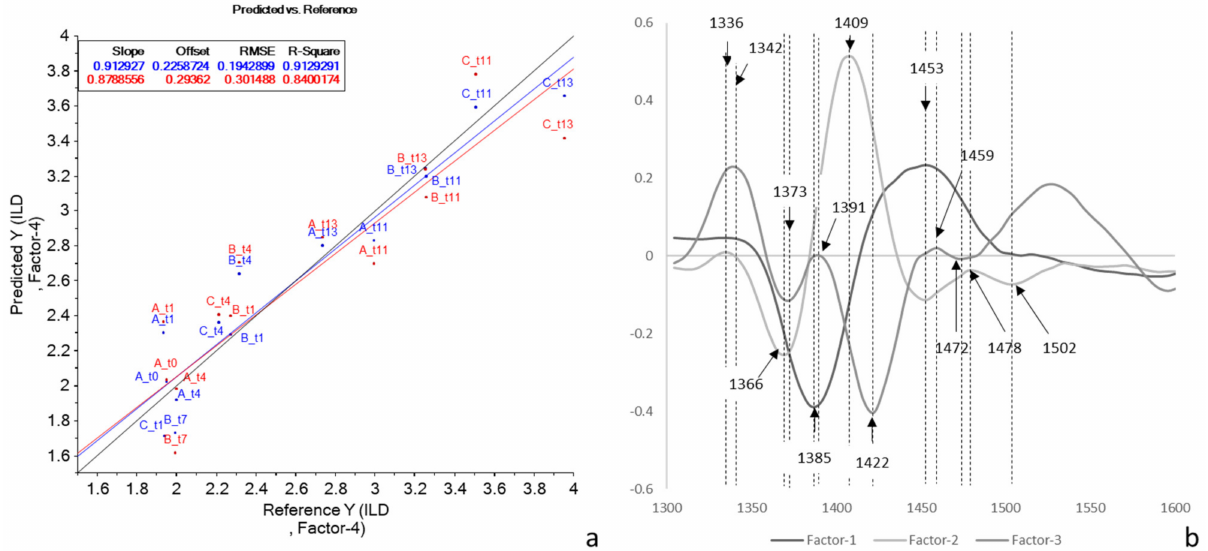
Figure 7. Scatter plot of calibration (blue) and cross validation (red)performance of predictive models built with pretreated NIR spectra and I LD values ( a ); PLS Factor Loadings ( b